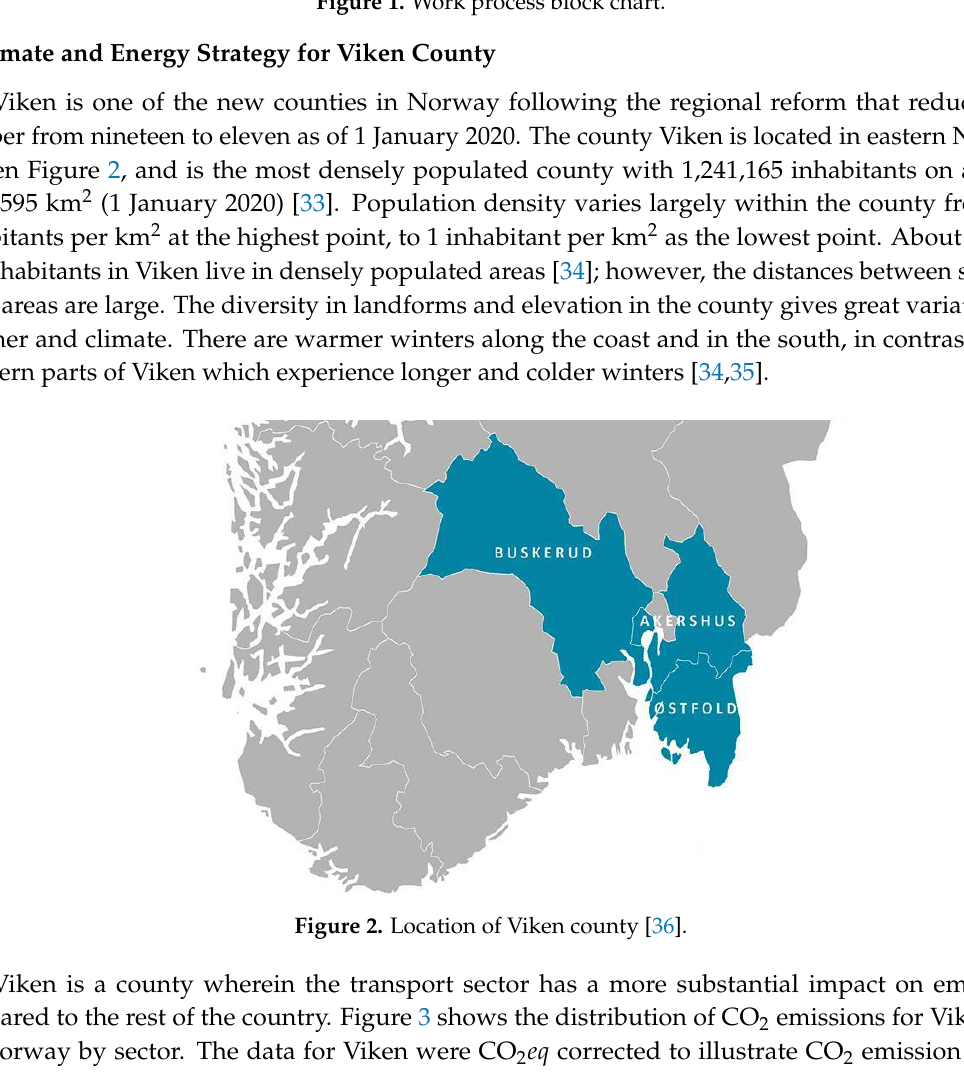
Figure 1. Work process block chart.